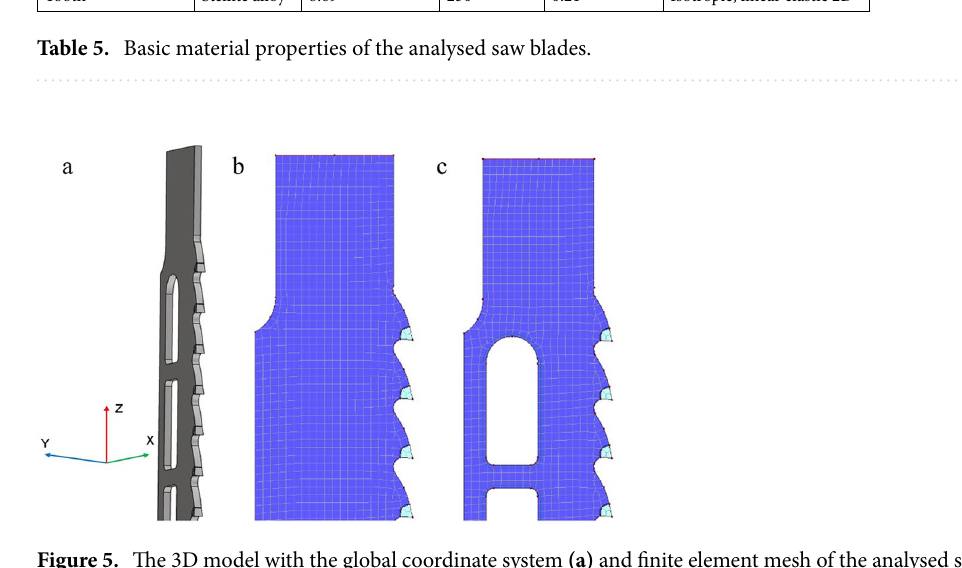
Figure 5. The 3D model with the global coordinate system (a) and finite element mesh of the analysed saw blades corresponding to the narrow-kerf blade (b) and the scraper saw blade (c) (drawing designed in